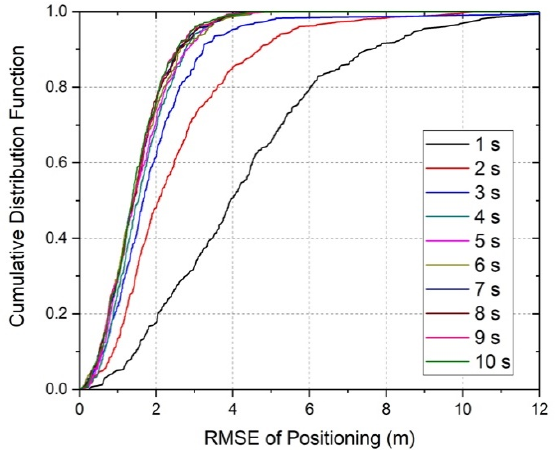
Figure 12. CDF comparison of the collection time by RMSE under di ff erent collection times (in Figure 12 . CDF comparison of the collection time by RMSE under different collection times (in seconds).